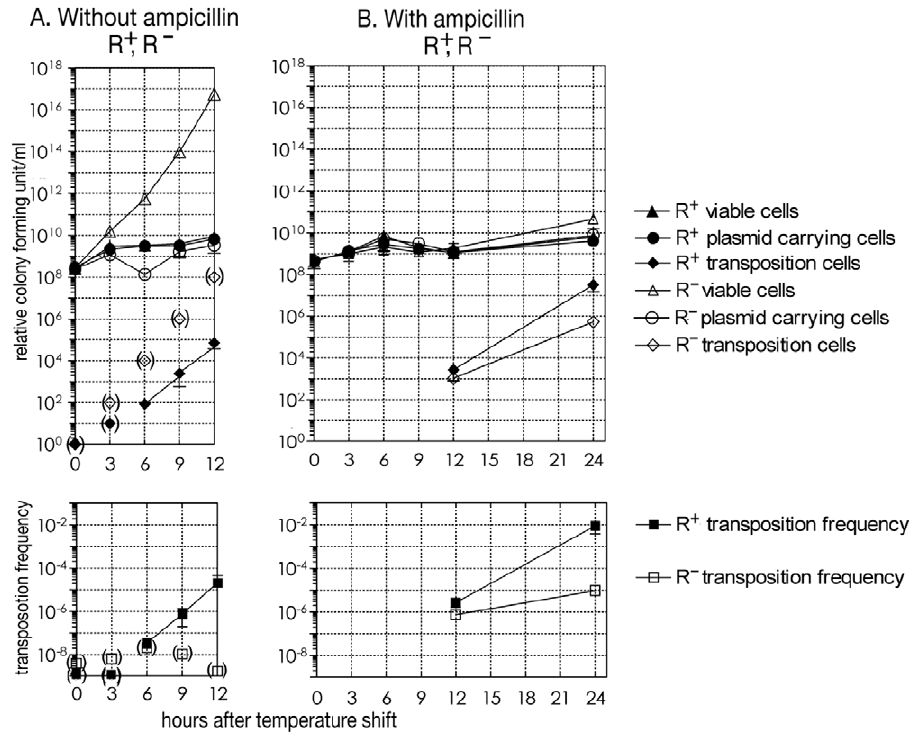
Figure 3. Detection of PaeR7I RM gene complex movement after replication block. A. (Series 1) E. coli cells carrying pSO429 (pSC101ts, PaeR7I R + M + , Amp r , Km r and Cm r ) or pSO431 (the R 2 version) were isolated and grown to log phase at 30 u C with the three selective antibiotics. Cells were then centrifuged and re-suspended in LB broth at 42 u C without antibiotics (hour 0). After incubation with aeration at 42 u C, an aliquot was spread on agar containing antibiotics and incubated overnight at 42 u C in order to select and screen for transposition clones as described in Figure 2. Viable cells were calculated from the number of colony formers on LB agar without selective antibiotics after incubation at 30 u C. Plasmid-carrying cells were calculated from the number of colony formers on LB agar with selective antibiotics after incubation at 30 u C. Transposition frequencies were calculated as (number of double drug-resistant cells per ml)/(number of viable cells per ml). Average values of six independent tubes were plotted. B. (Series 2) E. coli cells carrying pSO429 (R + ) or pSO431 (R 2 ) were grown and prepared for the temperature shift as in A. At hour 0, cells were centrifuged and re-suspended in LB broth containing a low dose (25 m g/ml) of Amp at 42 u C, and incubated with aeration at 42 u C. Aliquots were subjected to selection and screening as shown in Figure 2C and the transposition frequency, as well as the number of viable cells, plasmid-carrying cells were calculated as in A. The averages of 5 (R + ) or 4 (R 2 ) measurements were plotted. The upper graphs show relative colony forming unit and the lower graphs show calculated transposition